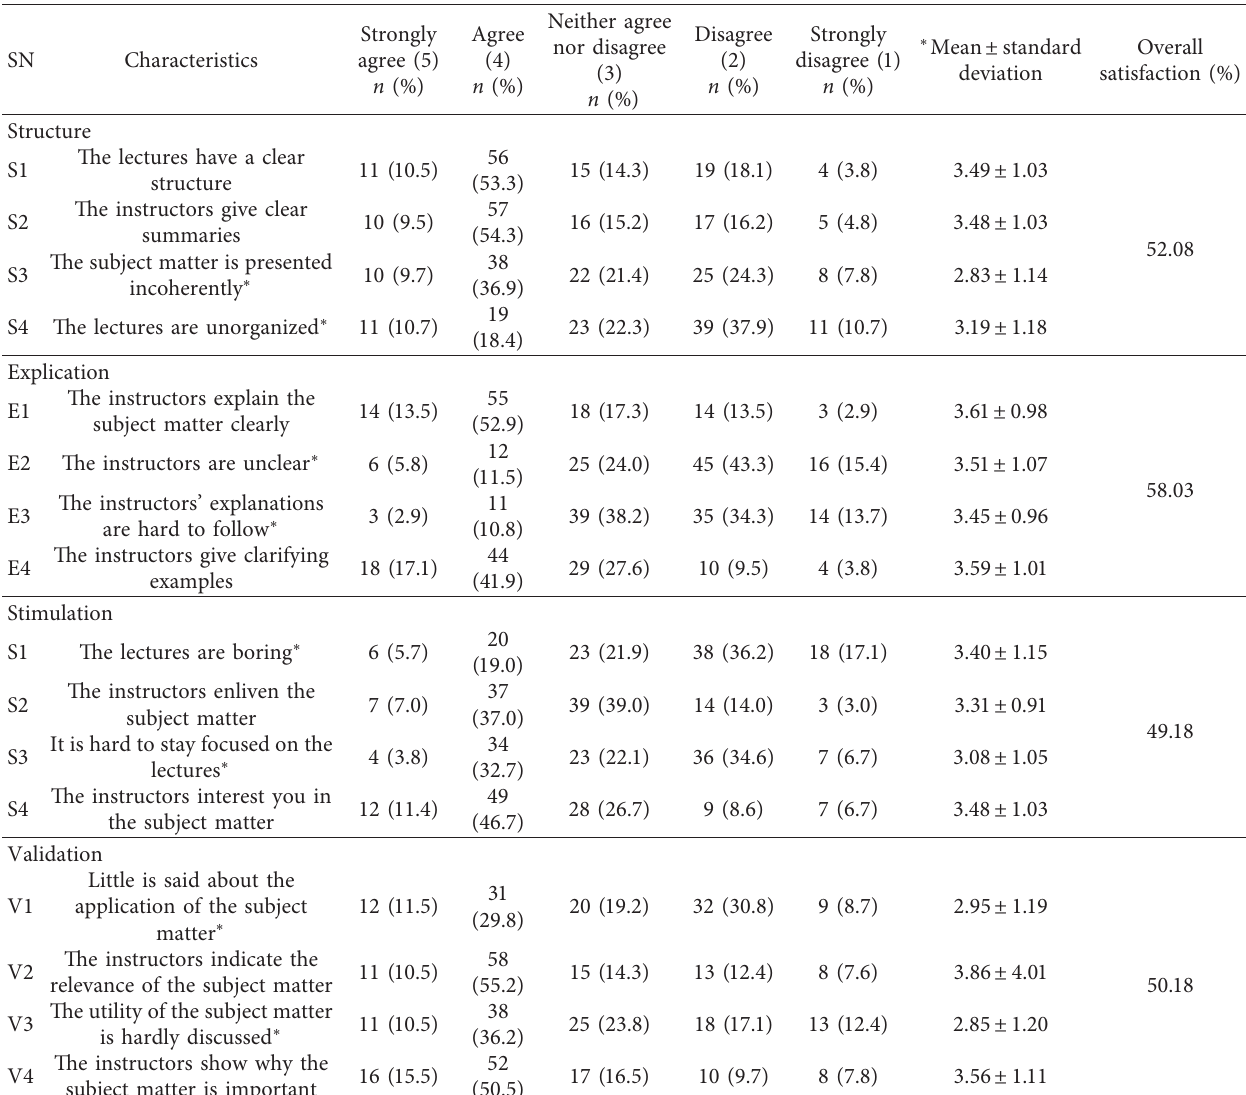
Table 2: Attainment of satisfaction levels in each characteristic ( N � 105).